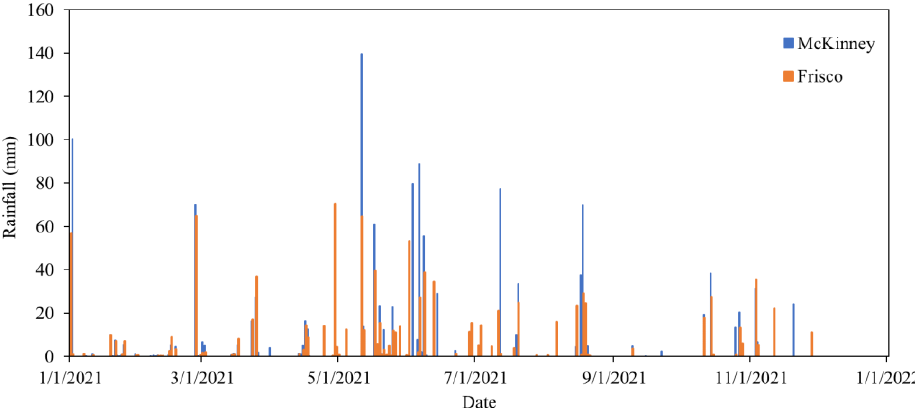
Figure 7. Rainfall data at McKinney and Frisco stations, Texas, U.S. in 2021.